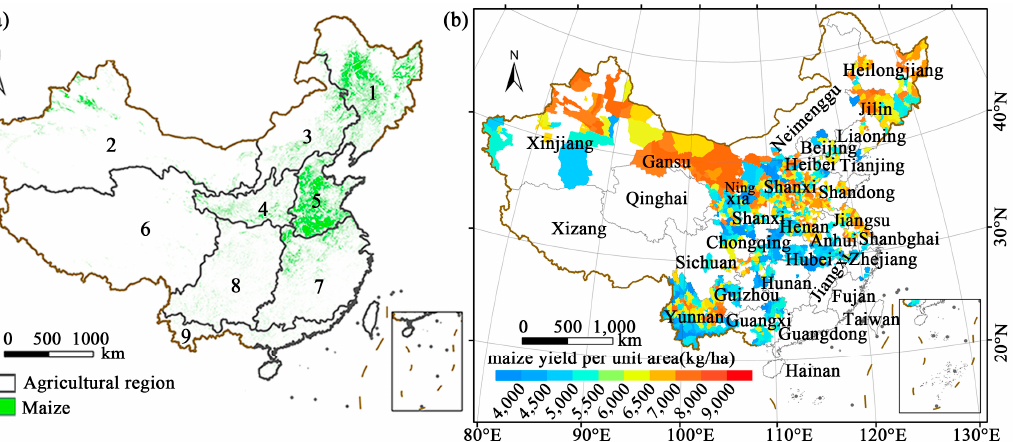
Figure 1. Map overview of the study area: ( a ) distribution of maize in 2018 and agricultural areas; ( b ) distribution of maize yield per unit area in 2018. Note: Agricultural region 1: Northeast China region, 2: Gansu new region, 3: the Inner Mongolia and region along the Great Wall, 4: Loess Plateau region, 5: Huang-Huai-Hai region, 6: Qinghai Tibet region, 7: Middle and lower reaches of the Yangtze River, 8: Southwest China, 9: South China.